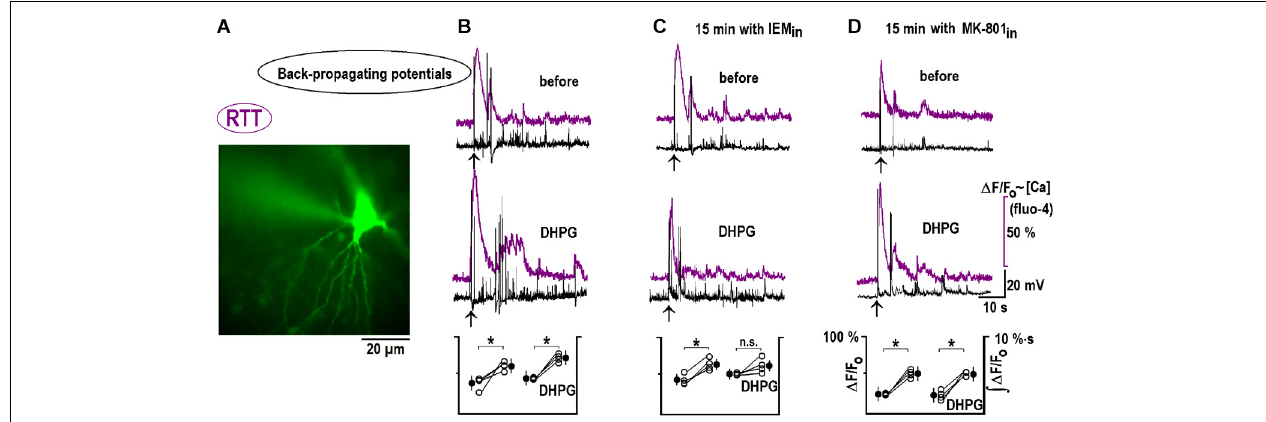
FIGURE 8 | DHPG modifies responses to back-propagating potentials in RTT. (A) Spatial distribution of Fluo-4 intensity at the peak of response to back-propagating potentials (bAP). (B) Typical responses before and after DHPG (top and middle traces, respectively). Mean calcium responses (violet) and voltage trajectories (black) were measured before and 10 min after DHPG (1 µ M for 30 s). Group summary at the bottom gives mean peak Fluo-4 transients during bAPs and fluorescence integral over 2 min after the stimulation (a measure of intensity of spontaneous afterdischarges induced by bAPs). The same protocol was applied to other slices where CA1 neurons were perfused intracellularly for 15 min with CP-AMPAR (C) and NMDAR (D) blockers as indicated. The data were evaluated with Student’s t -test with confidence levels of p < 0.05 ( ∗ ). The differences are significant, except non-significant (n.s.) changes in R ((cid:49) F / F 0 ) dt after DPHG in panel (C) . All calibration bars and notations in corresponding panels are the same and listed only once on the right. bAPs in WT are shown in Supplementary Figure S2B